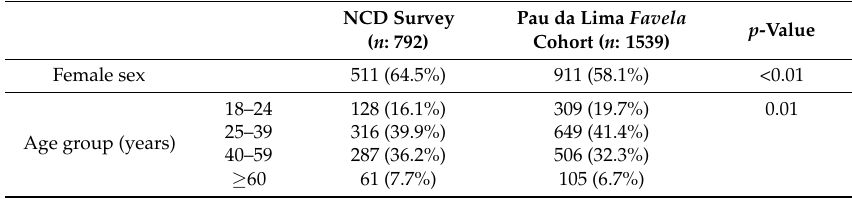
Table 1. Demographic and social characteristics of participants in the non-communicable disease (NCD) survey, compared to a random sample of residents of Pau da Lima favela , Salvador, Brazil, 2010. NCD Survey ( n :